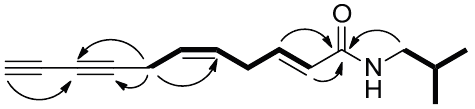
Figure 1. Selected COSY (bold line) and HMBC (arrow) correlations of 1